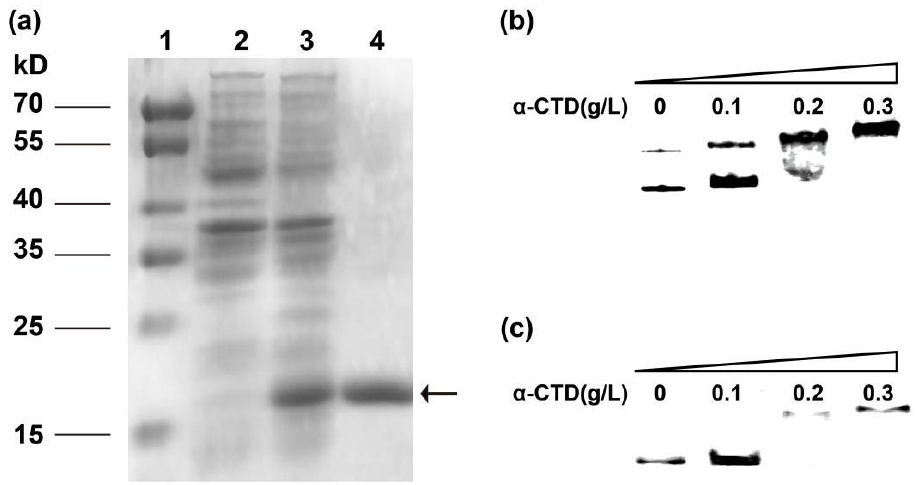
Figure 2. Purification of recombinant α -CTD and in vitro characterization of the interaction between α -CTD and P trxA /P Lan by EMSA. ( a ) Recombinant α -CTD was purified by using affinity chromatography. Lane 1 — standard molecular marker; lane 2 — cell lysate of the control DE3 strain; lane 3 — cell lysate of EcCTD; lane 4 —purified α - CTD. The molecular weight of recombinant α -CTD is indicated by an arrow. ( b ) EMSA gels of α -CTD protein with increased loading of oligonucleotide probes corresponding to P trxA . ( c ) EMSA gels of α -CTD protein with increased loading of oligonucleotide probes corresponding to P Lan .